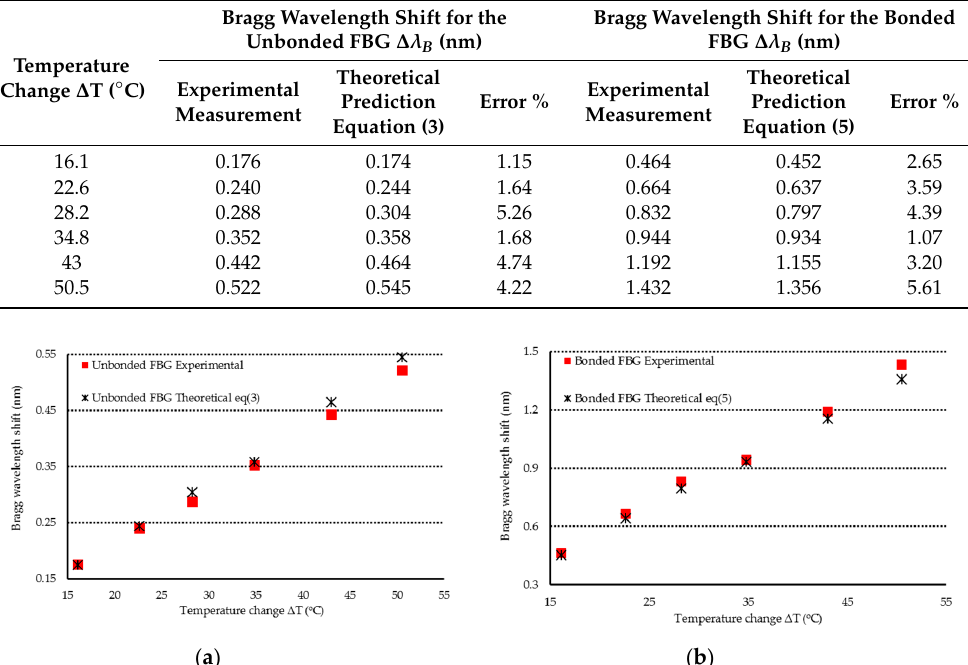
Figure 2. Optical spectrum reflected from the unbonded and bonded FBG due to a temperature of Δ T = 28.2 °C.